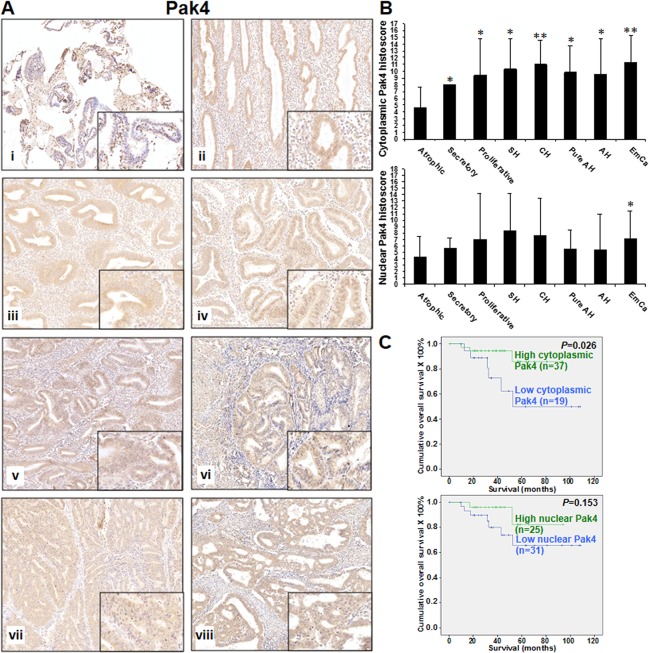
(A) Pak4 immunoreactivity in normal atrophic endometrium (i), secretory endometrium (ii), proliferative endometrium (iii), simple hyperplasia (iv), complex hyperplasia (v), pure atypical hyperplasia (vi), atypical hyperplasia (vii) and endometrial cancers (viii). (B) Bar chart showing the immunoreactivity of cytoplasmic (upper panel) and nuclear (lower panel) Pak4 in normal atrophic endometrium (Atrophic), secretory endometrium (Secretory), proliferative endometrium (Proliferative), simple hyperplasia (SH), complex hyperplasia (CH), pure atypical hyperplasia (Pure AH), atypical hyperplasia (AH) and endometrial cancers (EmCa). *, P<0.05; **, P<0.005; compared to normal atrophic endometrium by Mann-Whitney test. (C) Kaplan-Meier survival curves for endometrial cancer patients with two different expression levels of cytoplasmic (upper panel) and nuclear (lower panel) Pak4 (cut off at mean).